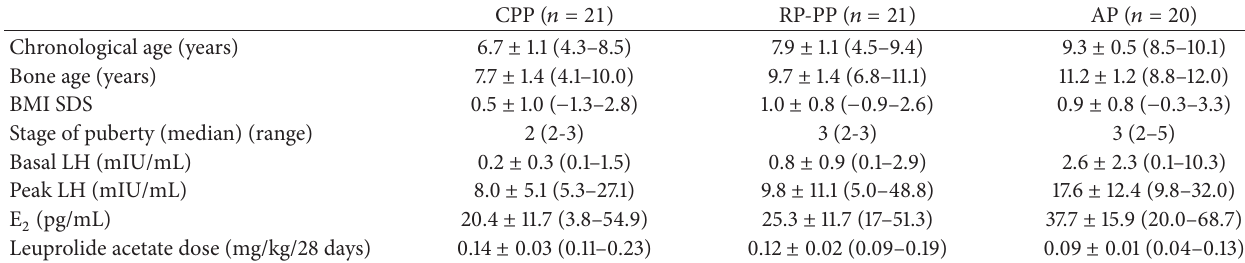
Table 1: Initial clinical/hormonal characteristics of the patients and treatment dose (mean ± SD) (range).